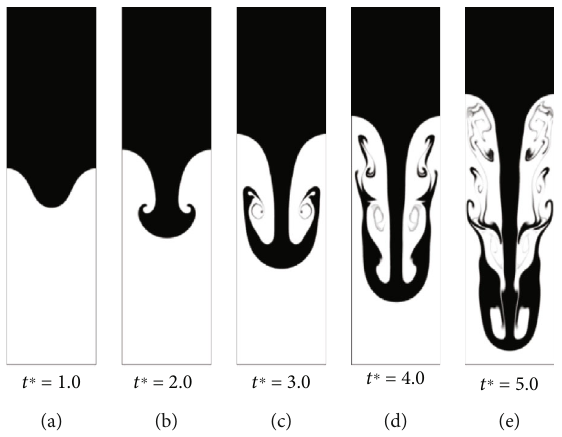
Figure 9: Snapshots of interface evolution for Re = 2048 and At = 0 : 5 .